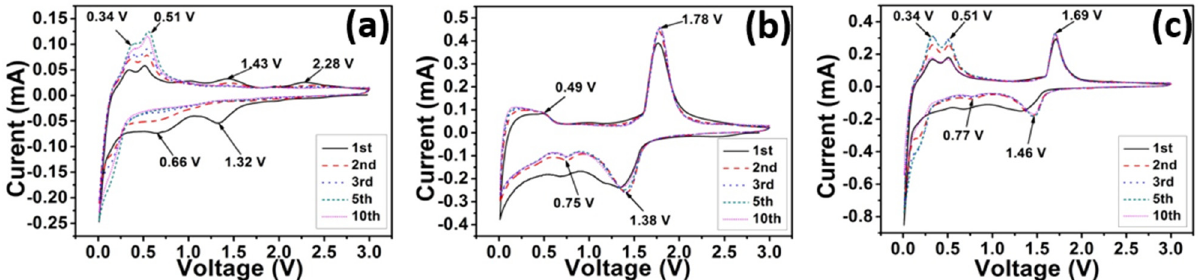
Figure 2. CV curves of electrodes based on ( a ) pure-Si, ( b ) pure-LTO, and ( c ) 50LTO20Si at scan rate of 0.2 mV s − 1 in the range of 0.02–3 V,